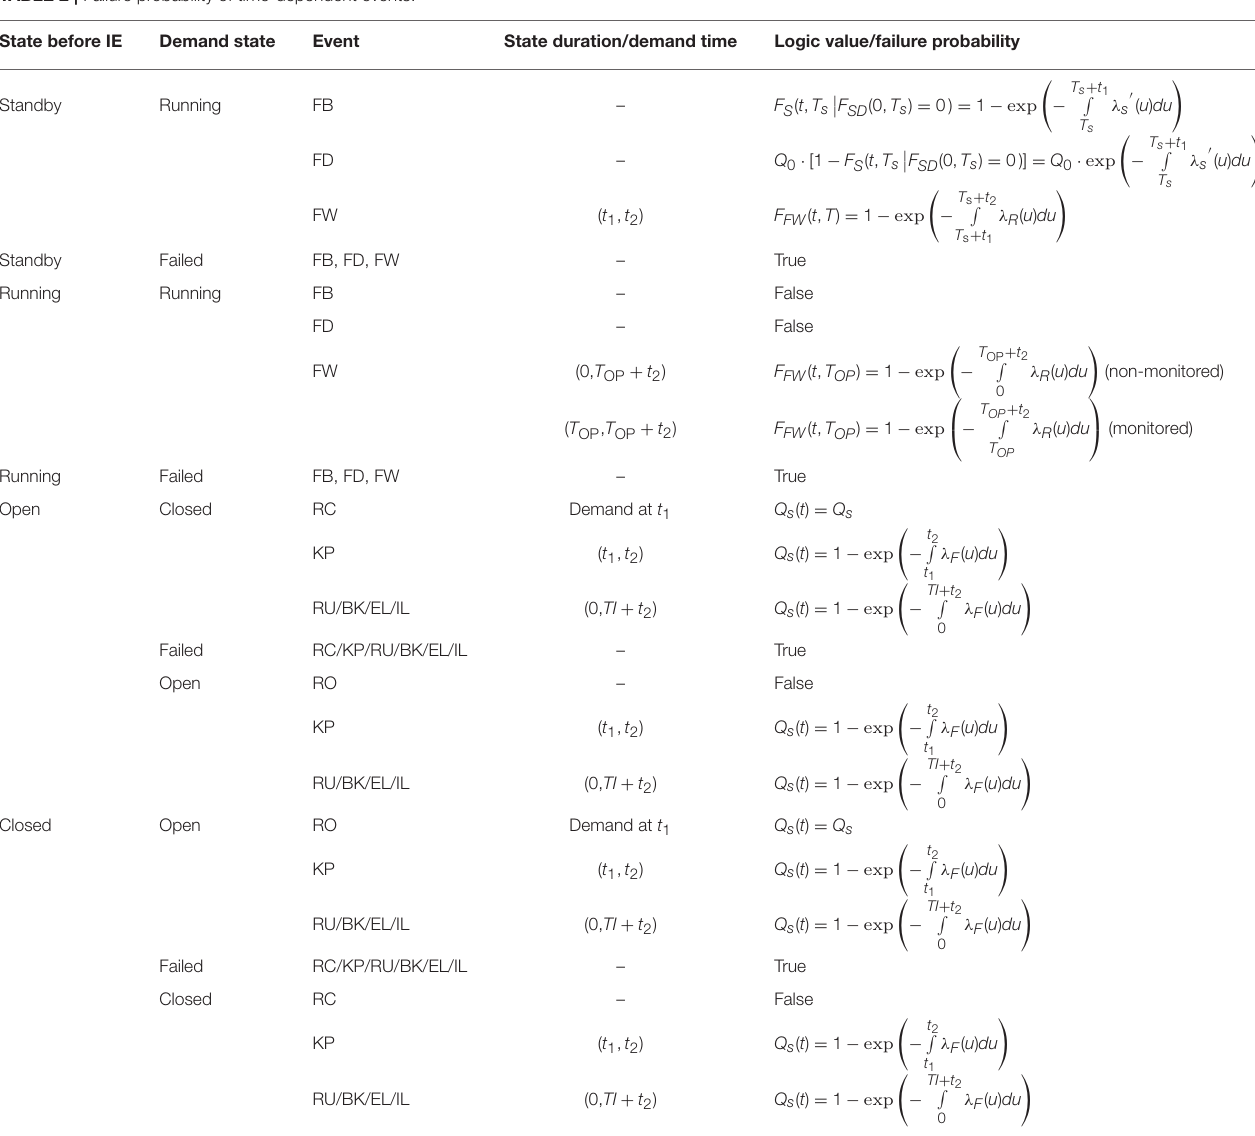
TABLE 2 | Failure probability of time-dependent